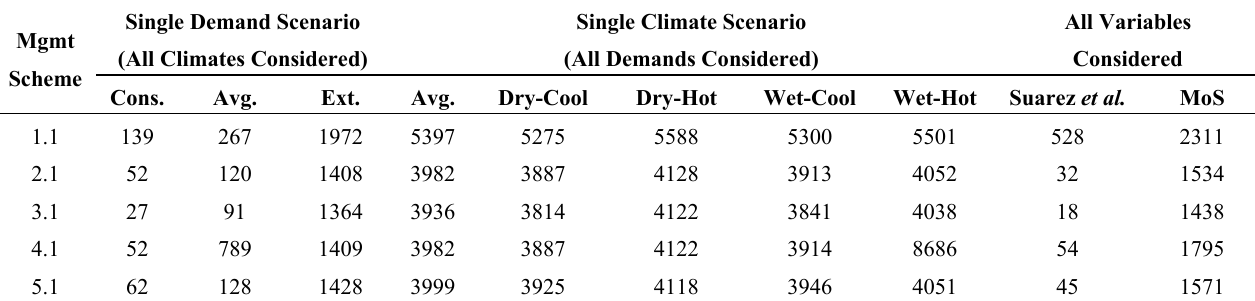
Table 13. Range of deficits introduced by uncertain variables in million m 3 , considering either a single demand scenario over all climates or a single climate scenario over all demands. To the right are projected deficits using the traditional and MoS